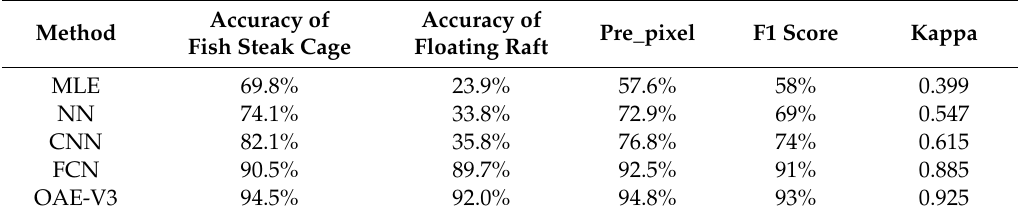
Table 1. Comparison of classification accuracy of di ff erent supervised classification methods for o ff shore aquaculture